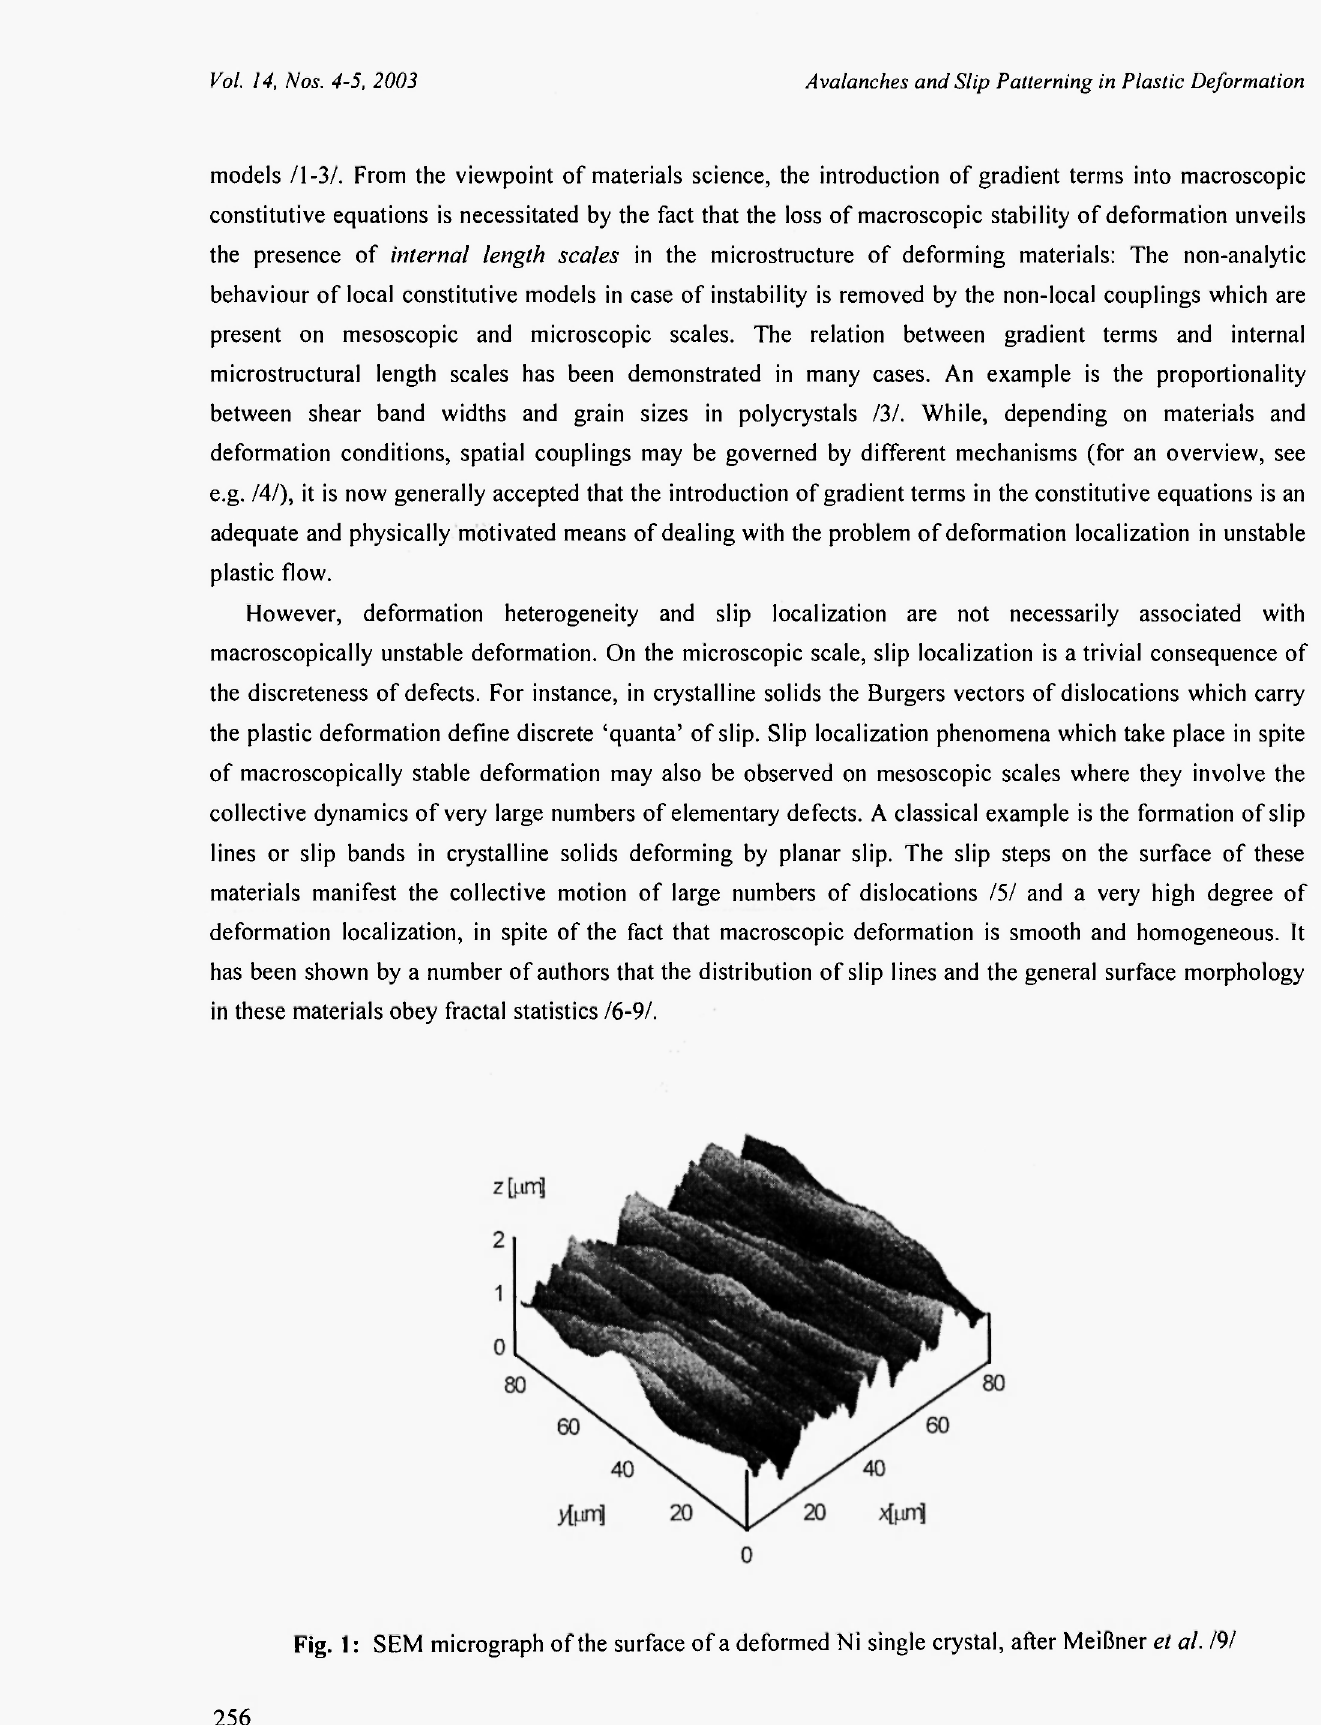
Fig. 1 : SEM micrograph of the surface of a deformed Ni single crystal, after Meißner et al. 191